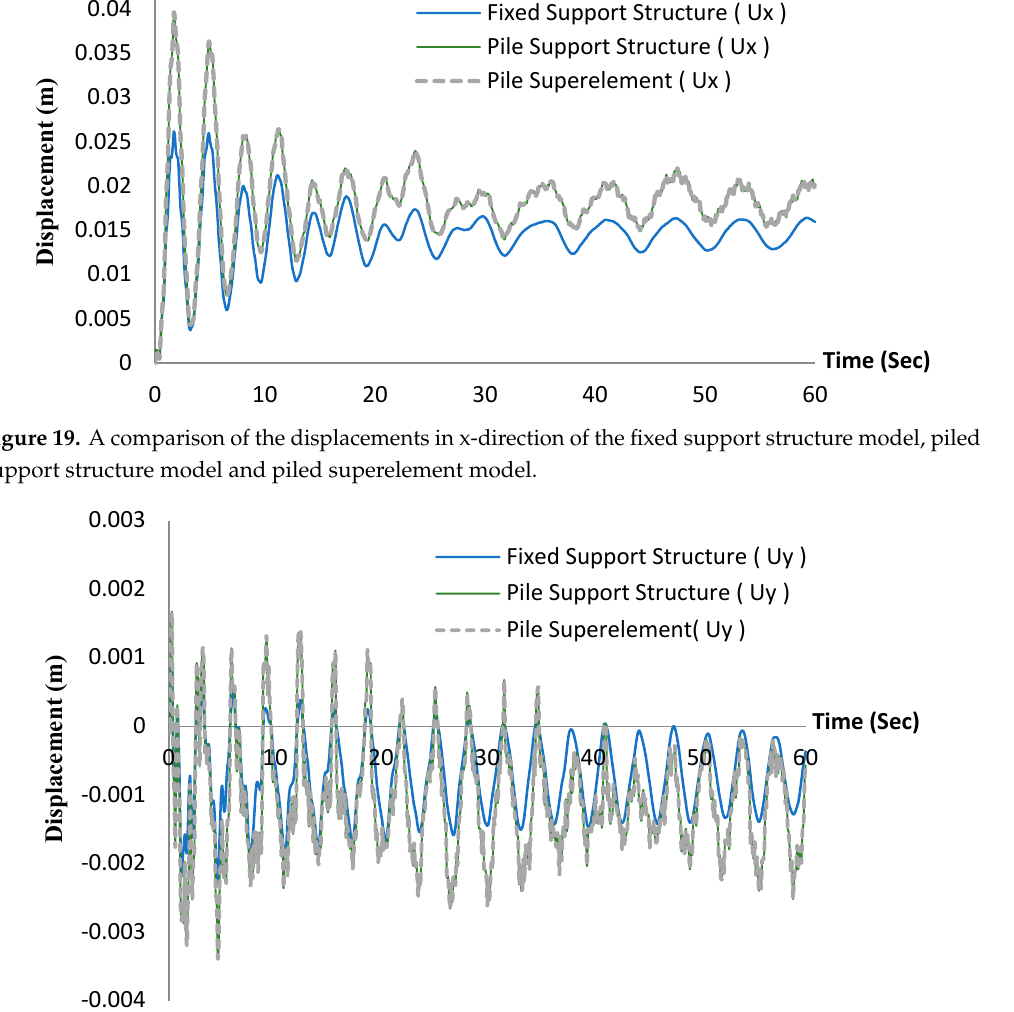
Figure 20. A comparison of the displacements in y-direction of the fixed support structure model, piled support structure model, and piled superelement model.